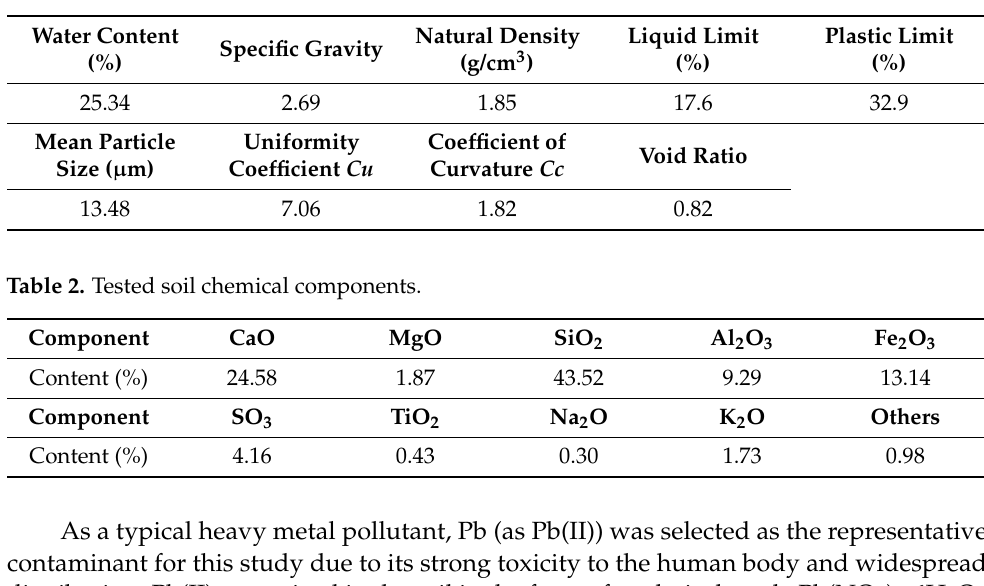
Table 1. Basic properties of tested soil.